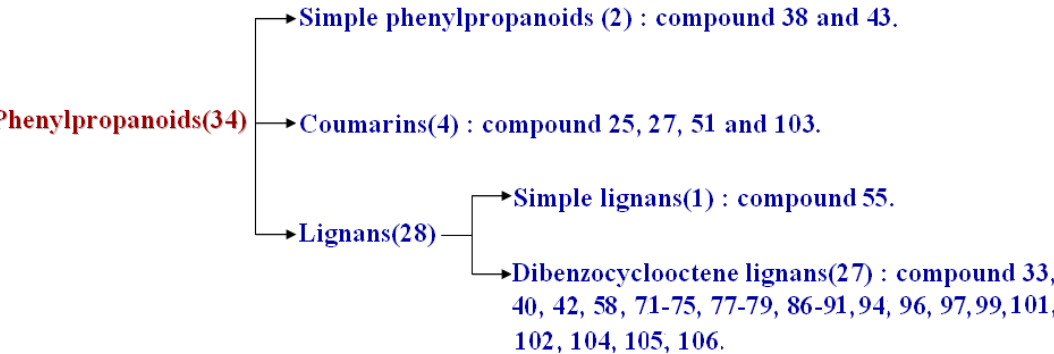
Figure 4. Phenylpropanoids identified in WZYZW by UPLC-ESI-LTQ-Orbitrap-MS.